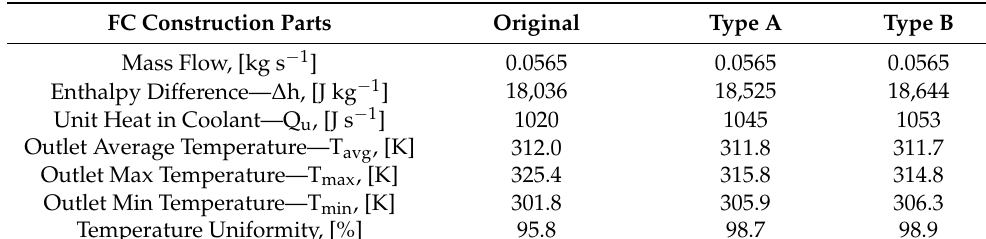
Table 4. Output values from analysis of CFD model.